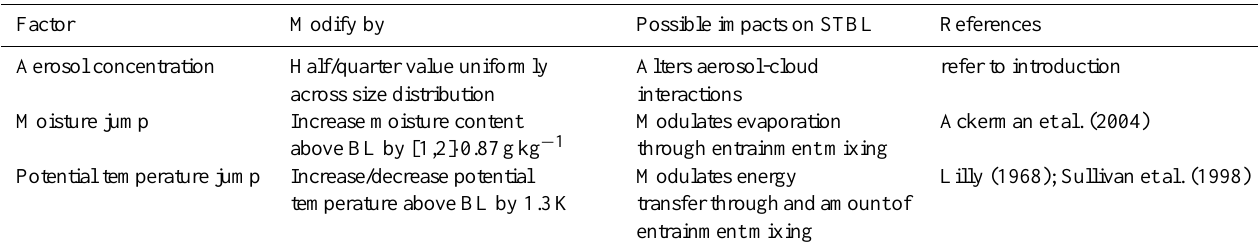
Table 4. Aerosol and meteorological properties varied and for which the response of cloud properties LWP, optical depth and cloud radiative forcing are